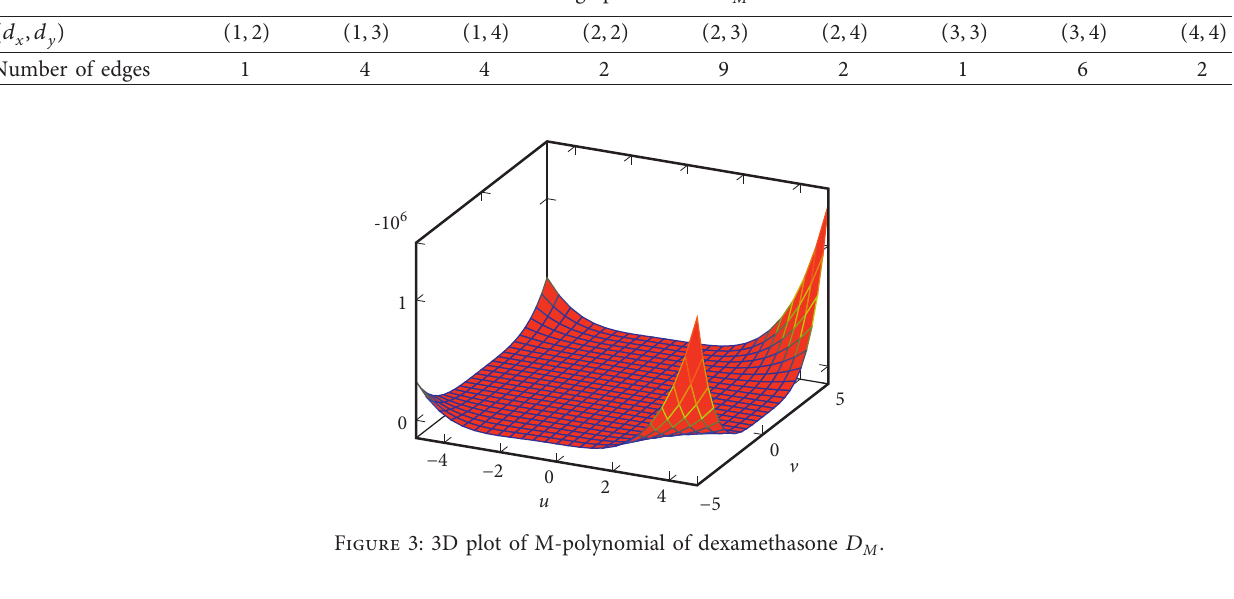
Table 2: Edge partition of D